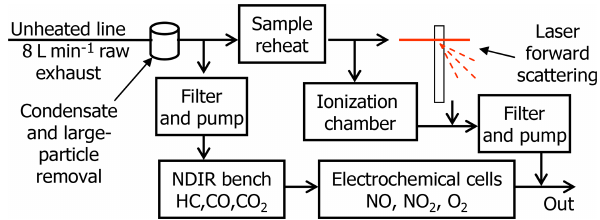
Figure 2. Schematic of the miniature portable on-board emissions monitoring system (Mini-PEMS); see text for